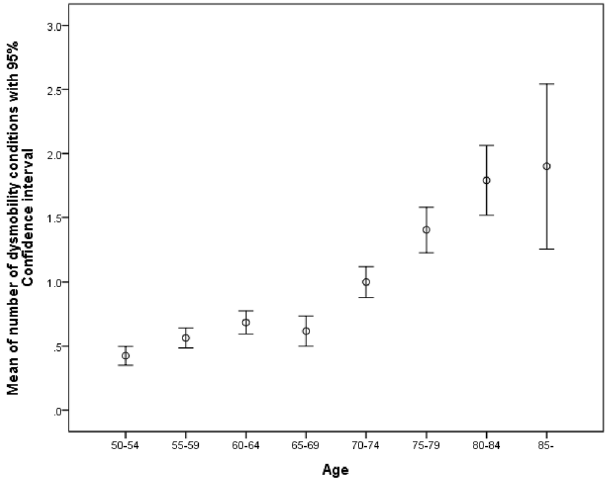
Figure 2. Mean of numbers of dysmobility conditions with 95% confidence interval versus age.